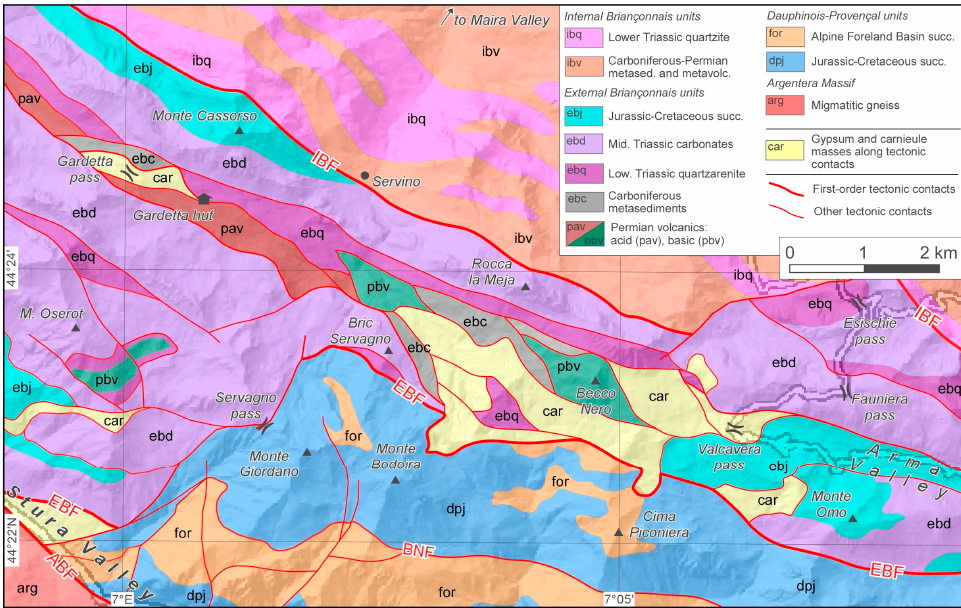
Figure 10. Geotectonic map of the Gardetta Deformation Zone, developed between the internal Briançonnais front (IBF) and the external Briançonnais front (EBF) (modified from [19]).